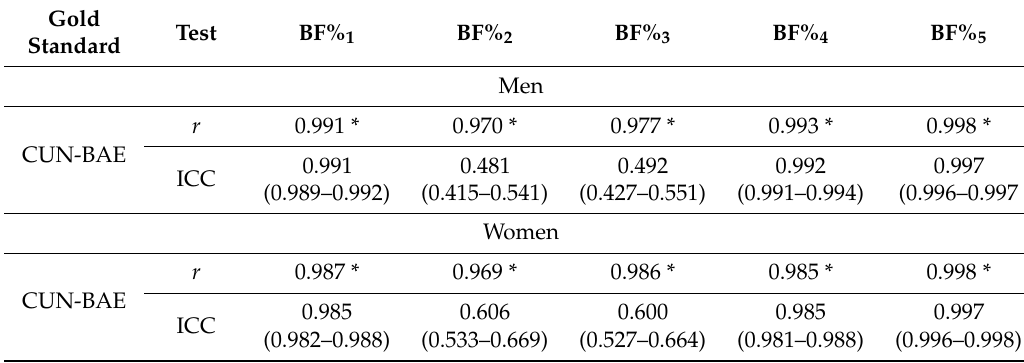
Table 5. Bivariate correlation and ICC by